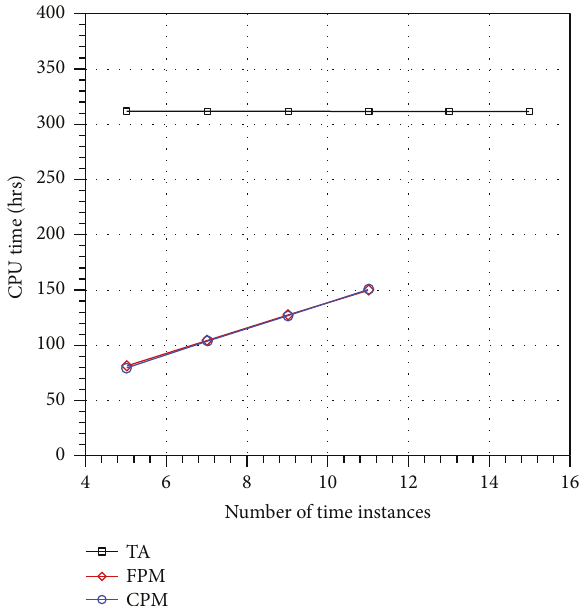
Figure 8: Computational time for ICE con fi guration under pitching motion.